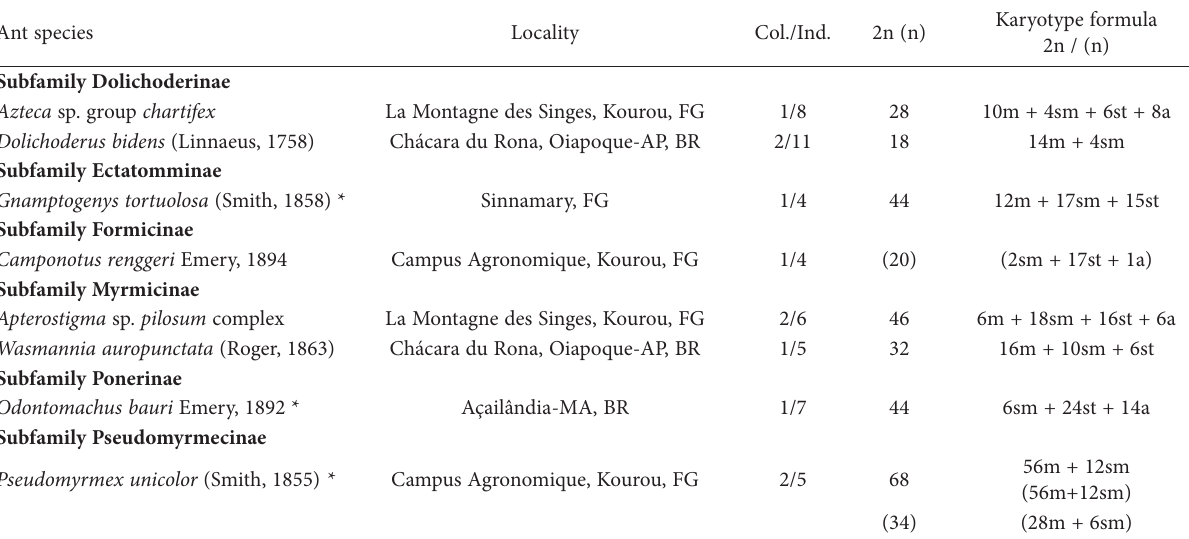
Table 1. Ant species collected from the Amazon rainforest and analyzed using classical cytogenetics. Collection sites, sample sizes (numbers of colonies/individuals), diploid (2n) and haploid (n) chromosome numbers, and karyotype formula. Ant